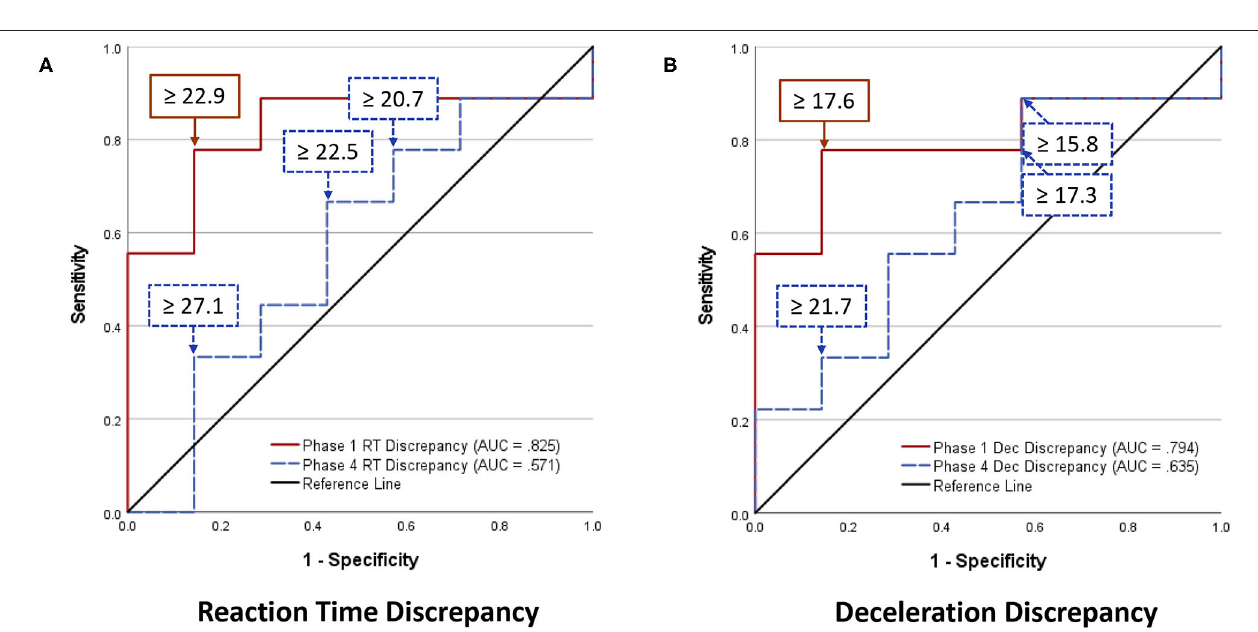
FIGURE 3 | Receiver operating characteristic curves identifying History of Sport-Related Concussion cases in early phase (red solid line; sessions 1–3) and late phase (blue dashed line; sessions 10–12) of 12-session whole-body reactive agility training program on the basis of Discrepancy (maximum–minimum difference) among t-scores for 2 movement directions and 4 task modes: (A) Reaction Time Discrepancy, (B) Deceleration Discrepancy.